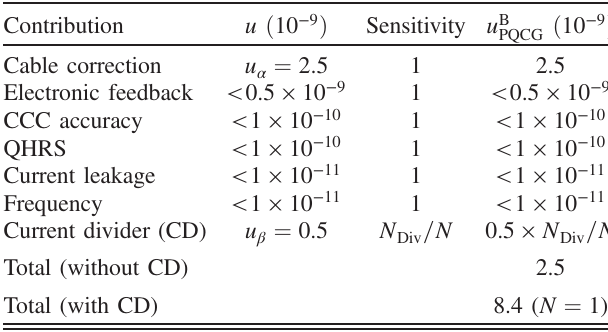
TABLE II. Type B standard uncertainty budget of